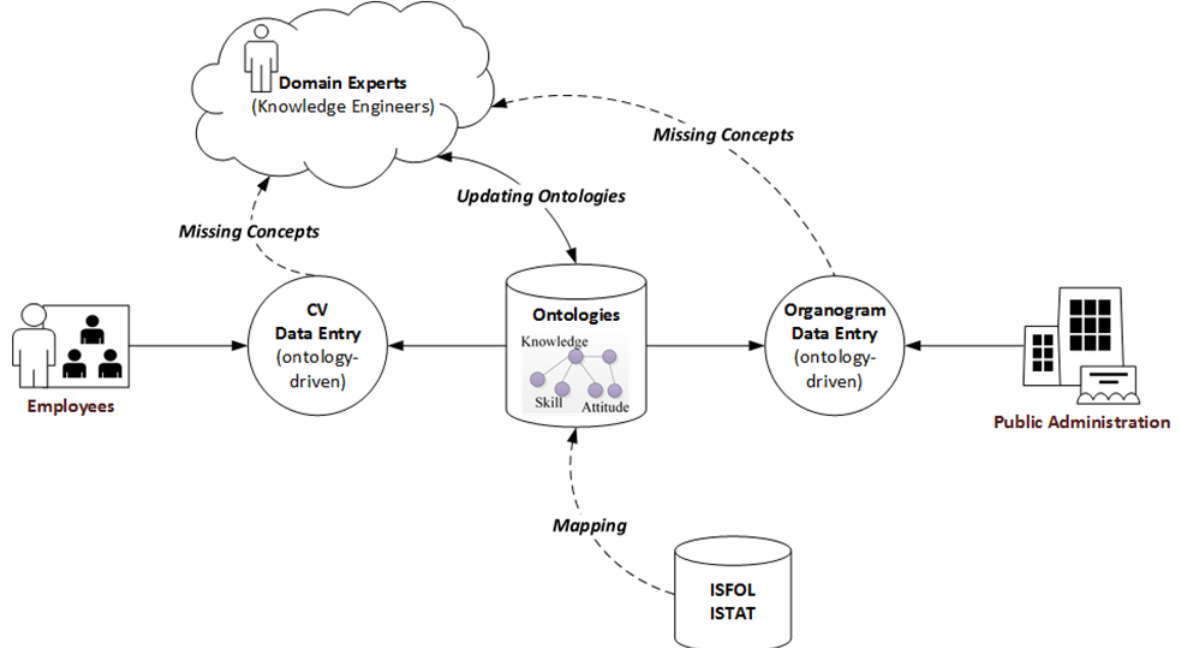
Figure 1. Model for the co-creation of value by means of a Collective Knowledge